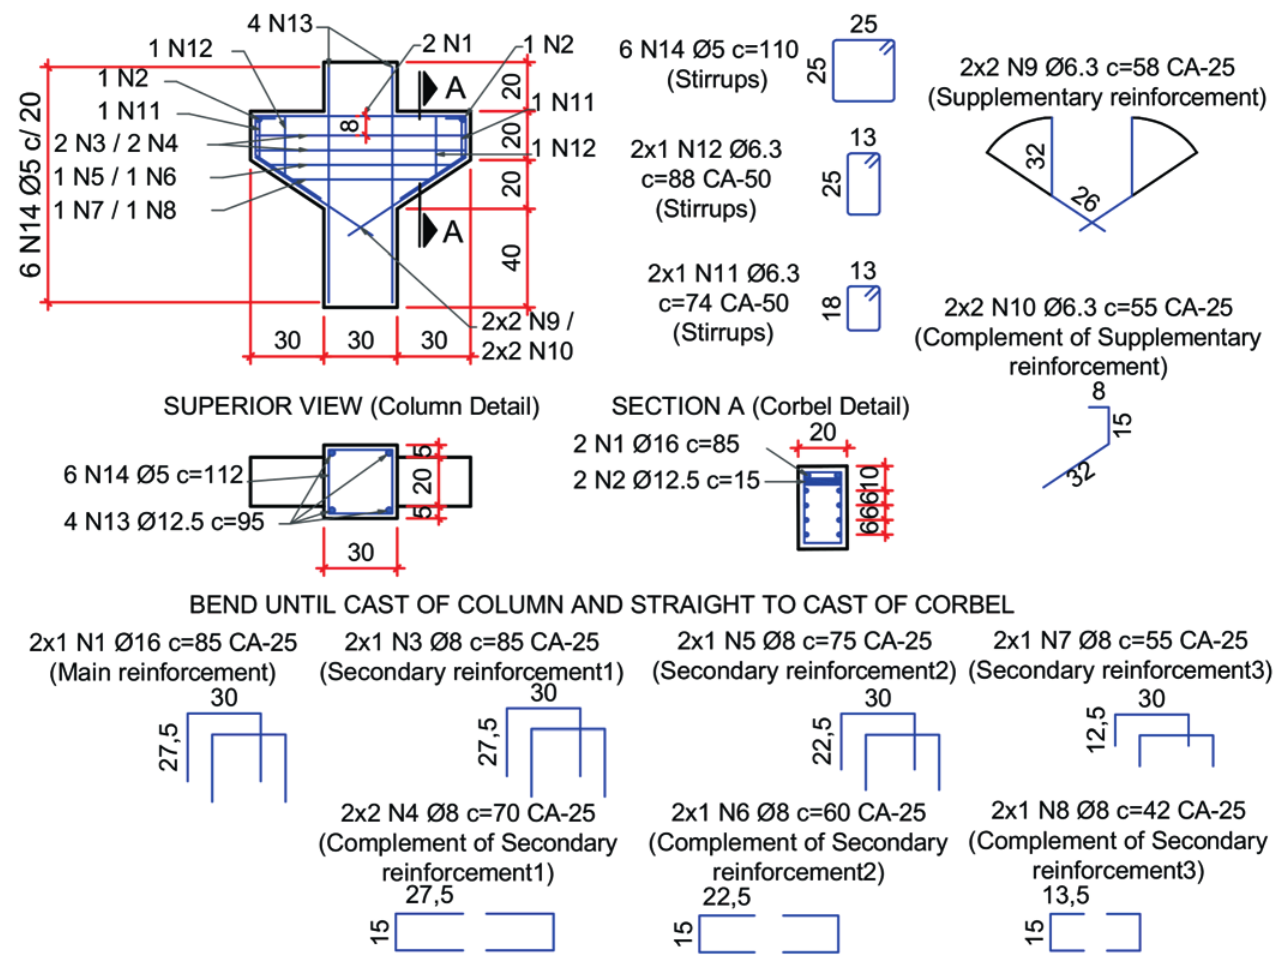
Reinforcement detail of models with corbels cast in different stage from the column (P4 and P5) with